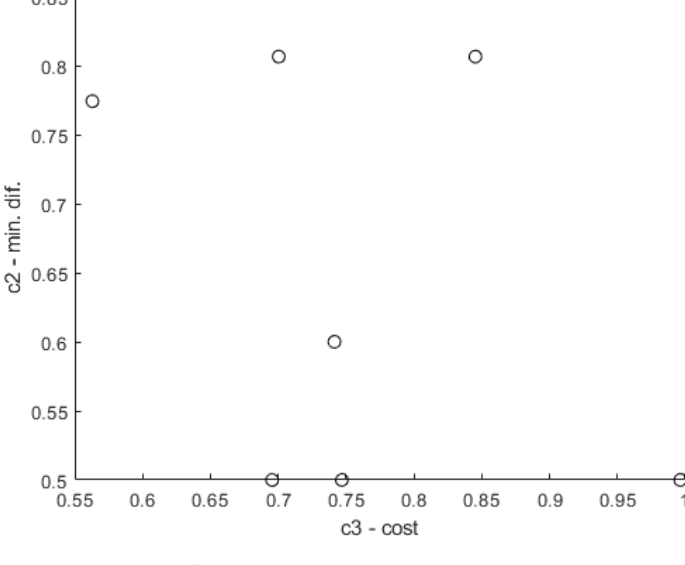
Figure 10. LHS result .